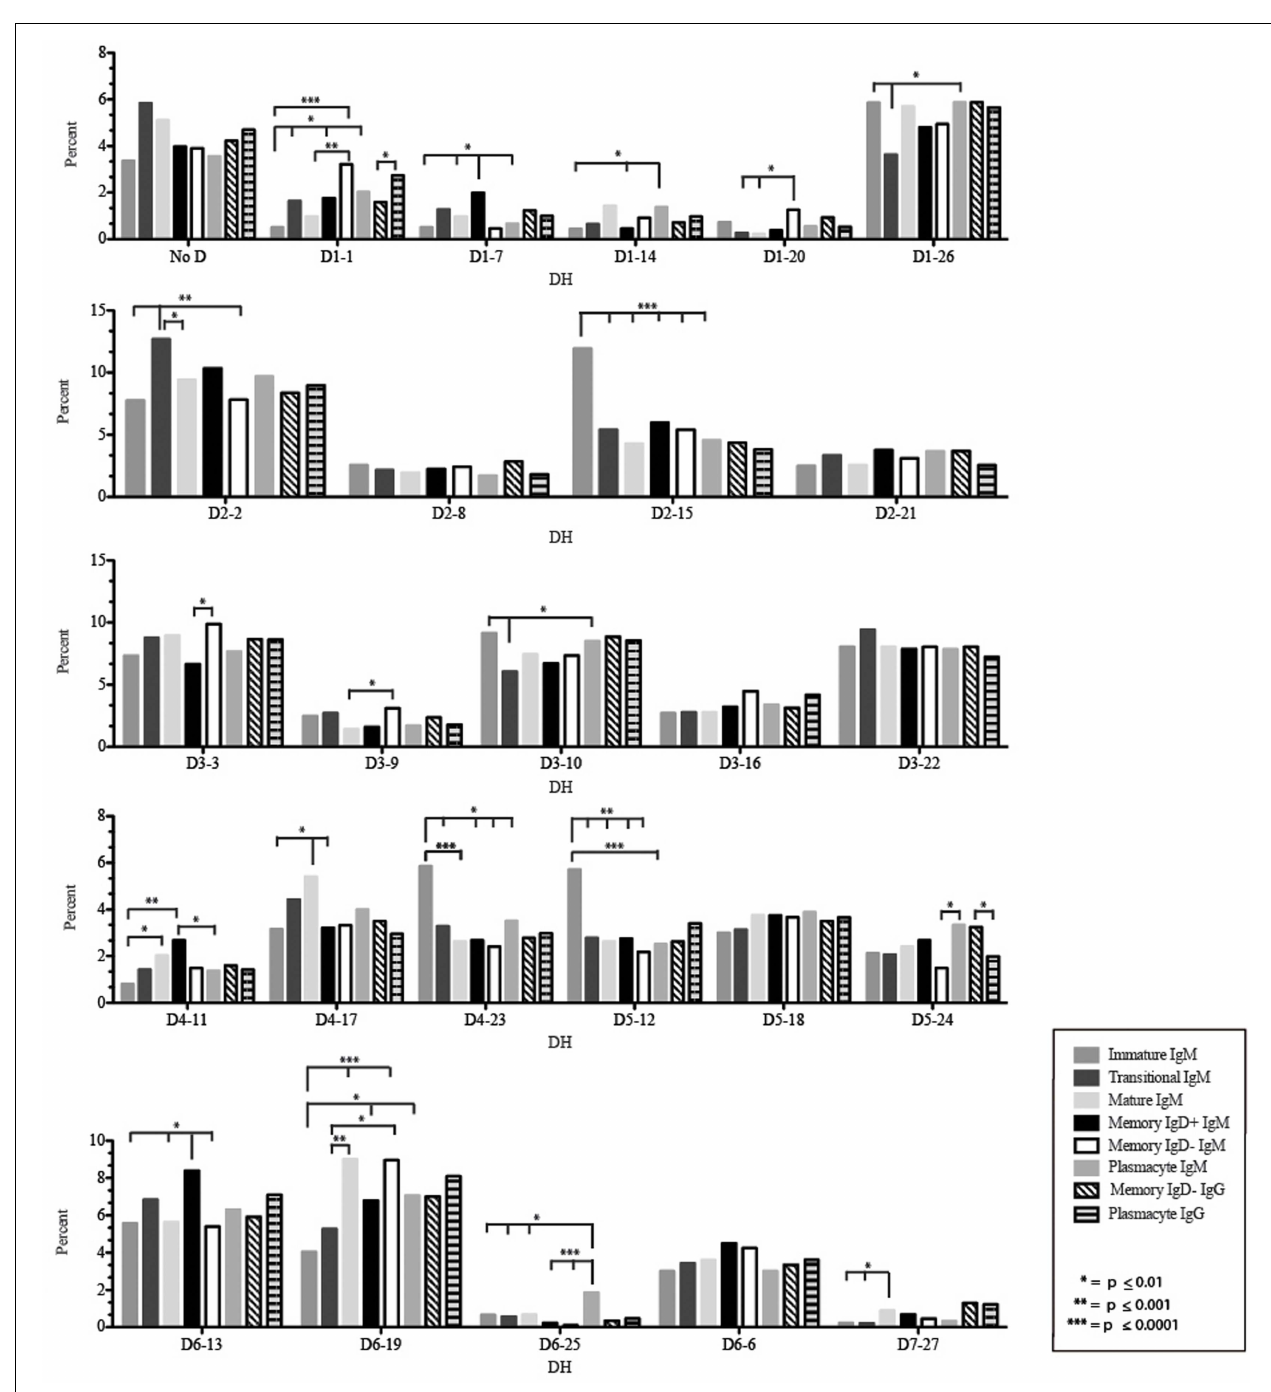
mature, memory IgD + , memory IgD − B cells, and plasmacytes are displayed. All comparisons were made using χ 2 -test or Fisher’s exact test as appropriate. Significant differences among each fraction in the different mice are indicated by asterisks: * p ≤ 0.01, ** p ≤ 0.001, *** p ≤ 0.0001.